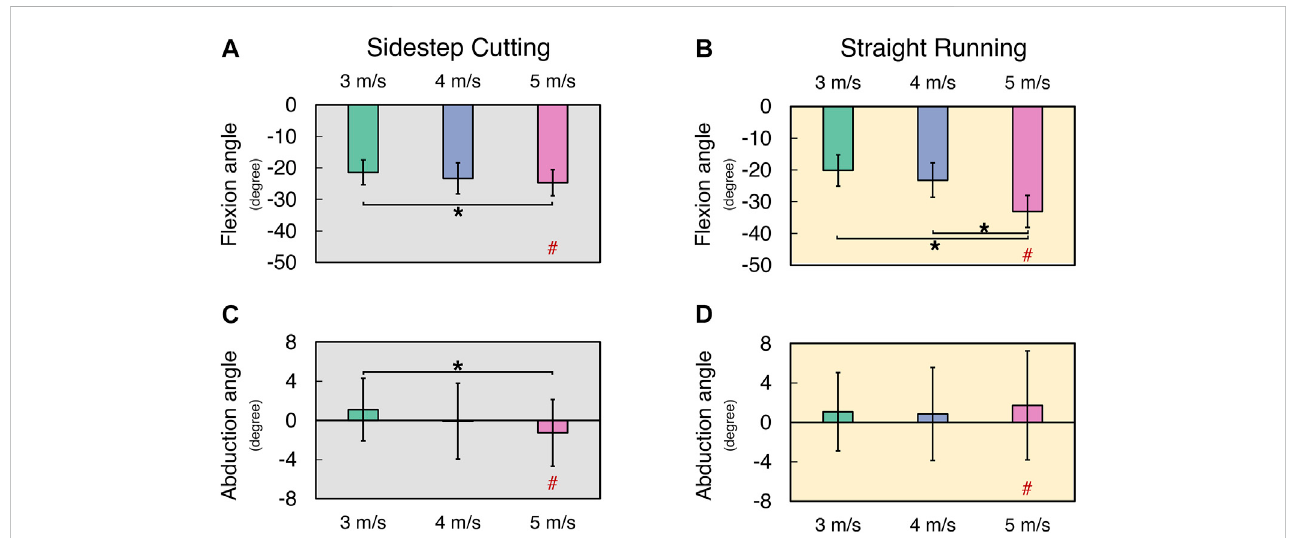
FIGURE 2 The mean and standard deviation of calculated variables during sidestep cutting ( Gray ) and straight running ( Yellow ). (A,B) Peak knee fl exion angle, (C,D) Peak knee abduction angle. Note: Units expressed in degrees. Knee extension, adduction, and internal rotation are positive. Signi fi cant differences between VELOCITY denoted by asterisks (*) ( p < 0.05). Signi fi cant differences between running TYPES for each condition denoted by hash (#) ( p < 0.05).